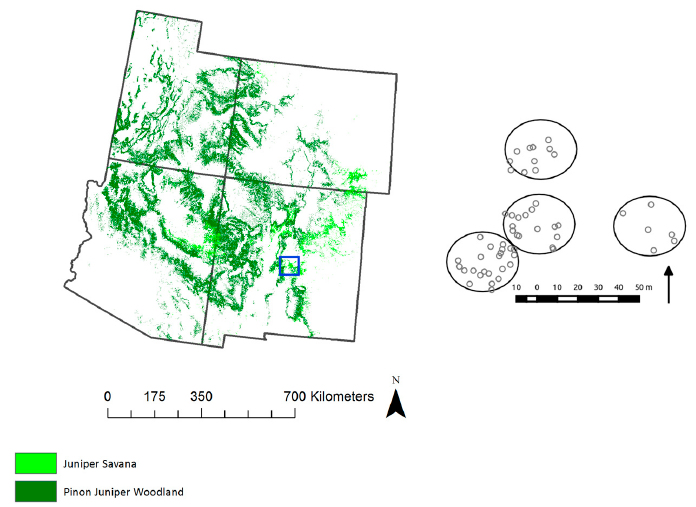
Figure 1. Extent of piñon juniper woodlands (PJ, dark green) and juniper savanna (JSAV, light green) ecosystems across the four corner states. (Right) Location and layout of the field site, with tree crown locations bounded by the four 17.5-m radius circle plots.